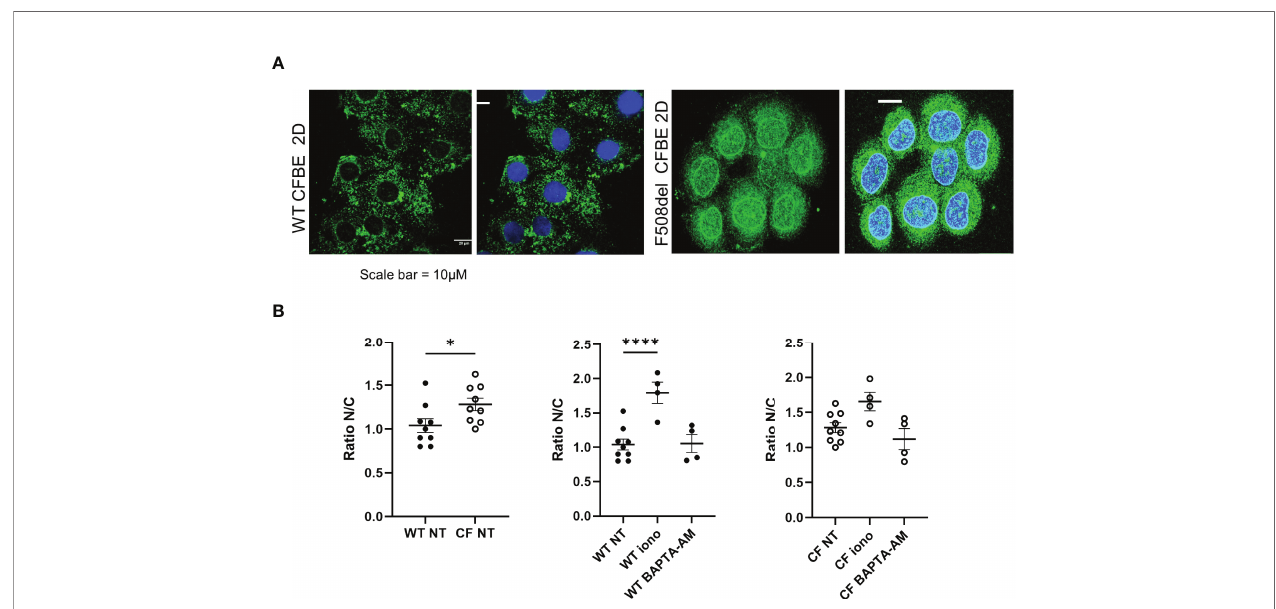
FIGURE 10 | Localization of the 5-LO in the in CFBE41o- cell line. (A) Intracellular localization of the 5-LO in CFBE41o- cell line expressing WT CFTR and F508del CFTR grown on glass coverslips. (B) Effect of ionomycin and BAPTA-AM on the 5-LO localization evaluated by the quanti fi cation of the nucleus/cytoplasmic ratio of 5-LO staining. *p < 0.05 and ****p < 0.0001.